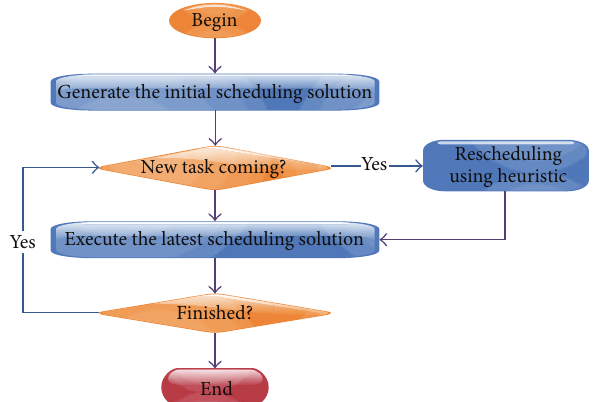
Figure 1: The basic framework of proposed